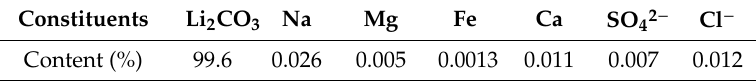
Table 10. Comparison of the Li + recovery between this study and conventional methods.